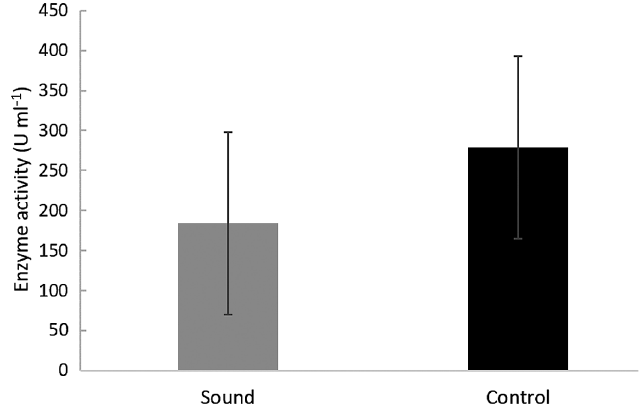
Fig. 3. Whiteleg shrimp haemolymph phenoloxidase mean activity (U ml –1 ) (individual animal means, n = 7 and 9, re - spectively) in sound and control treatments at experimental completion after 8 wk. Error bars = 1 SD